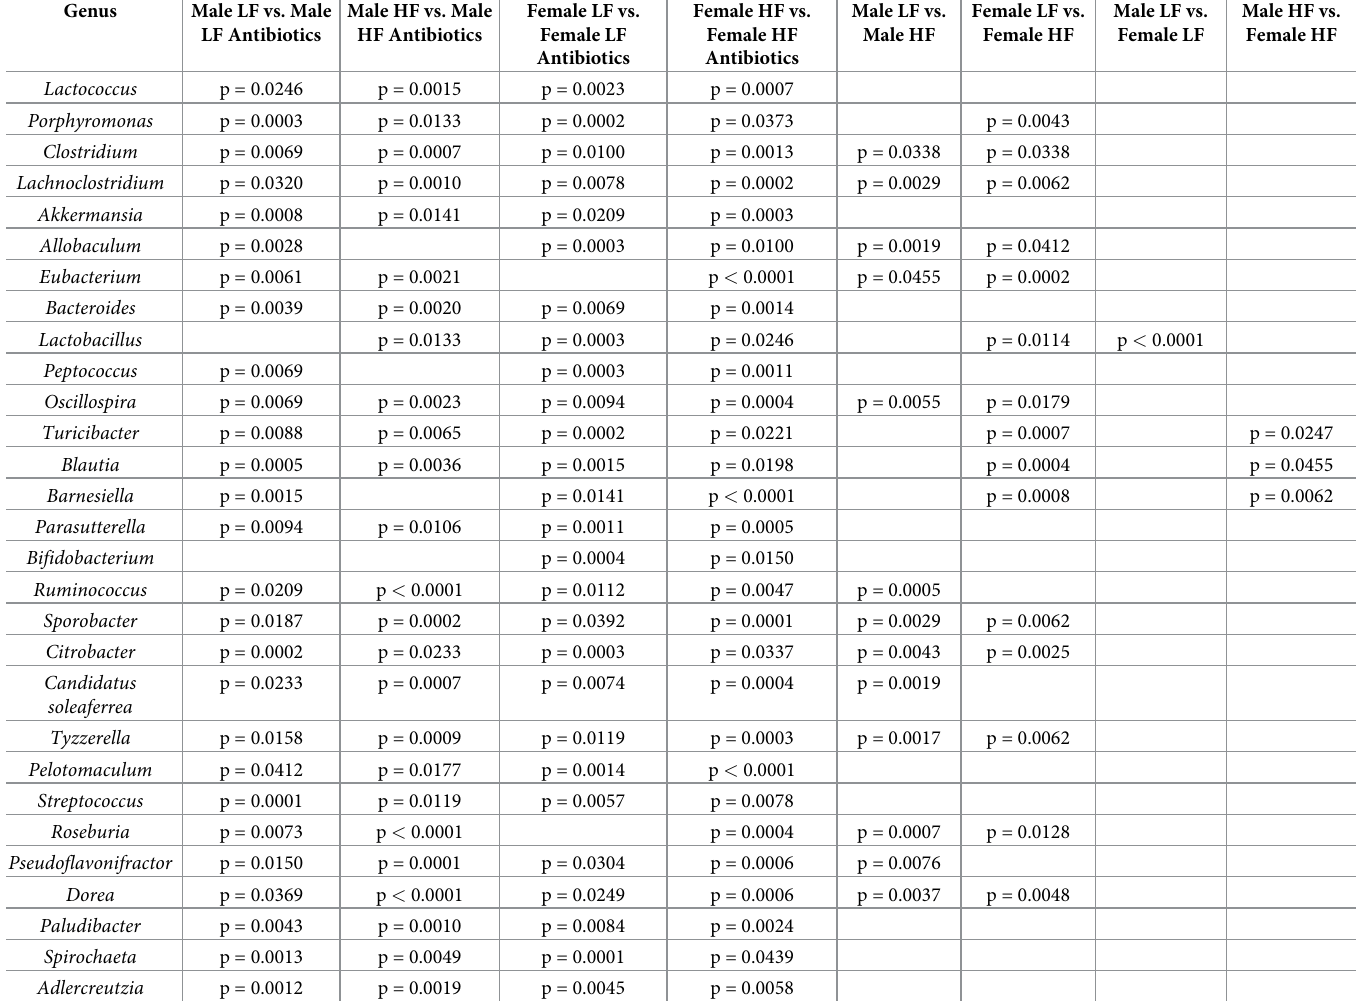
Table 1. Statistically significant differences in gut microbiome relative